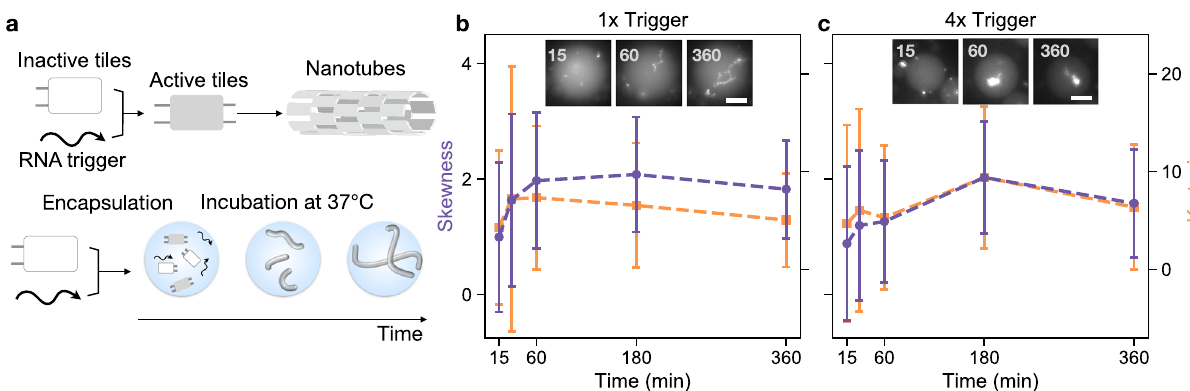
Fig. 4 Isothermal assembly of hybrid DNA-RNA nanotubes inside compartments at 37 °C. a Inactive DNA tile, lacking sticky-ends necessary for self- assembly on one side of the tile, is activated by the addition of RNA molecules and triggers self-assembly into nanotubes. Inactive tiles and trigger RNA are mixed immediately before encapsulation and incubated at 37 °C. b , c Representative fl uorescence microscopy images of droplets encapsulated with 500 nM inactive tiles, and 1x and 4x RNA trigger (insets) with plots of mean skewness (purple) and kurtosis (orange). Data were presented as mean values ± standard deviation. Data extracted using droplet detection code as described in Supplementary Note S4.13. The number of droplets sampled and a histogram data of radii for sampled droplets in Supplementary Note S5.9 and S5.10. Source data for this fi gure is provided as a source data fi le. Scale bars: 20 μ